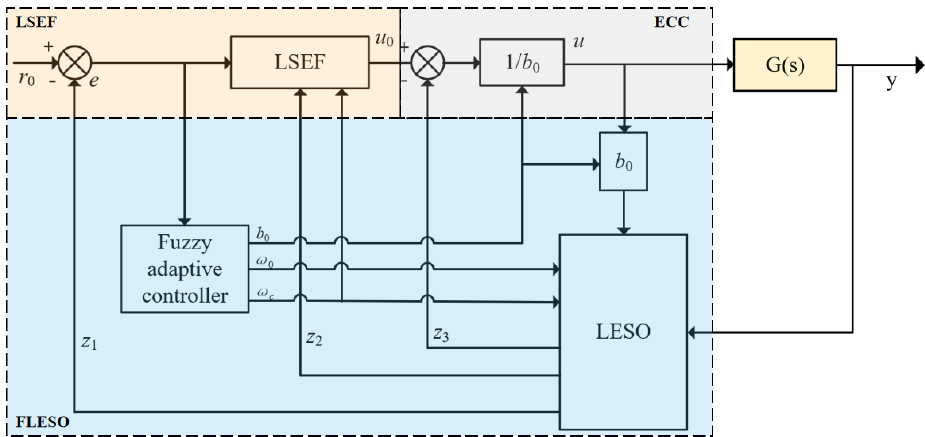
Figure 4. The structure and components of fuzzy adaptive linear active disturbance rejection control (Fuzzy-LADRC).